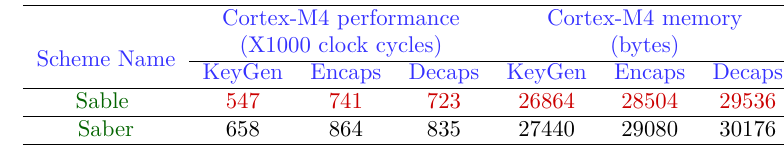
Table 8: Performance comparison in Cortex-M4 implementation of embedded Sable with embedded